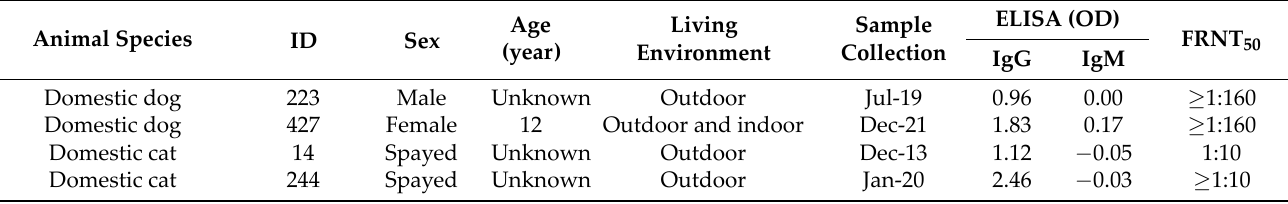
Table 2. Information regarding SFTSV‑positive